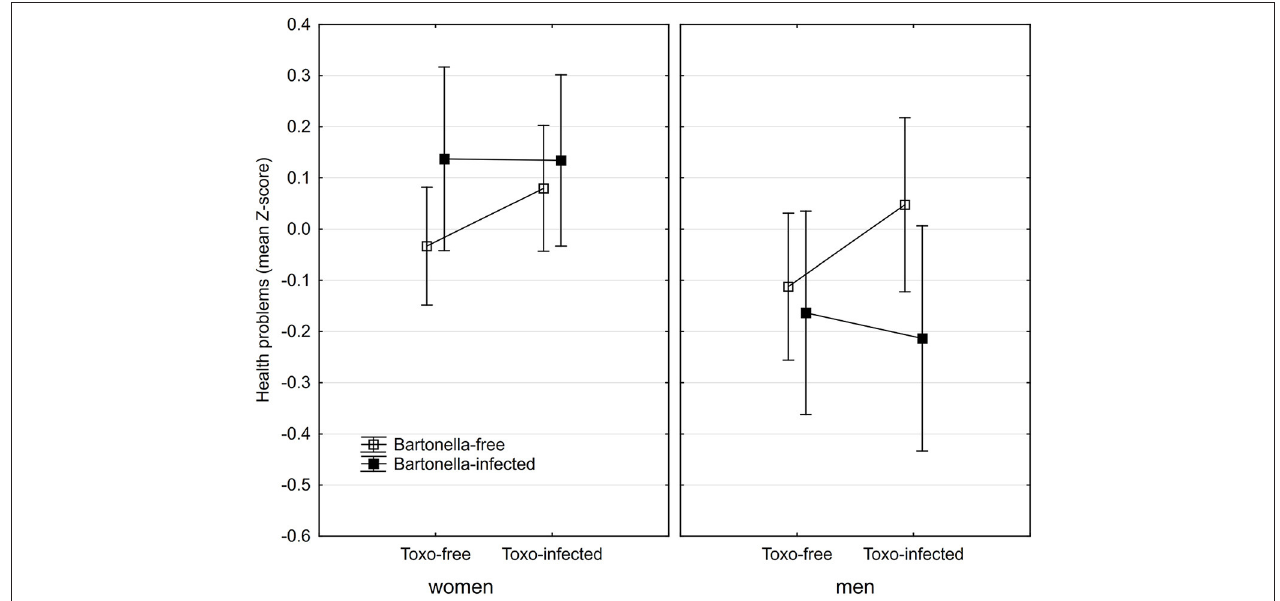
FIGURE 3 | Health status of Bartonella - and Toxoplasma -seropositive subjects. Squares show the intensity of health problems computed for covariates at their means and spreads 95% confidence intervals.